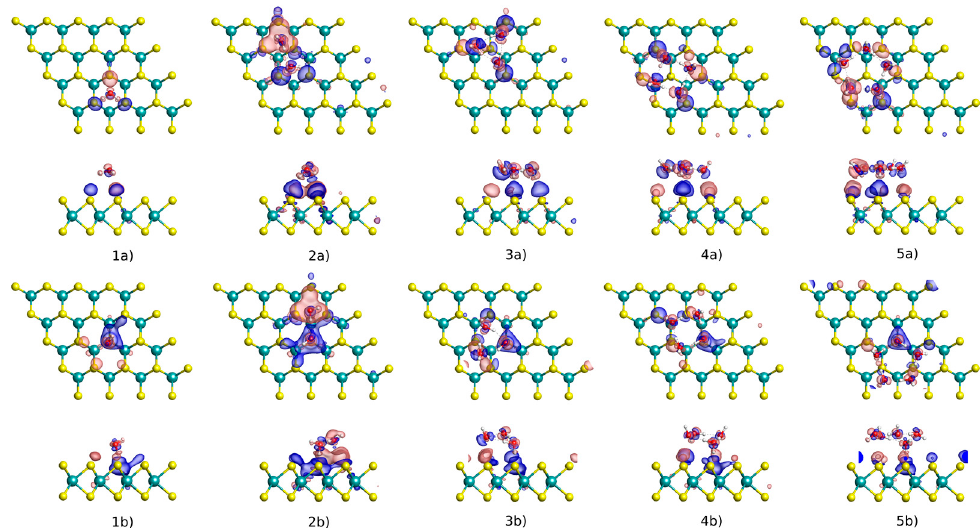
Figure 4. Charge density difference plots for (H 2 O) n ( n = 1–5) on the pristine and defective MoS 2 monolayers by vdW-DF-cx functional. The notations of ( 1a – 5a ) and ( 1b – 5b ) correspond to the pristine and defective surfaces, respectively; numbers 1–5 correspond to the number of water molecules on the surface. The red (blue) distribution corresponds to charge accumulation (depletion). The isosurface value of 0.005 e − /Bohr 3 is considered for all the cases.